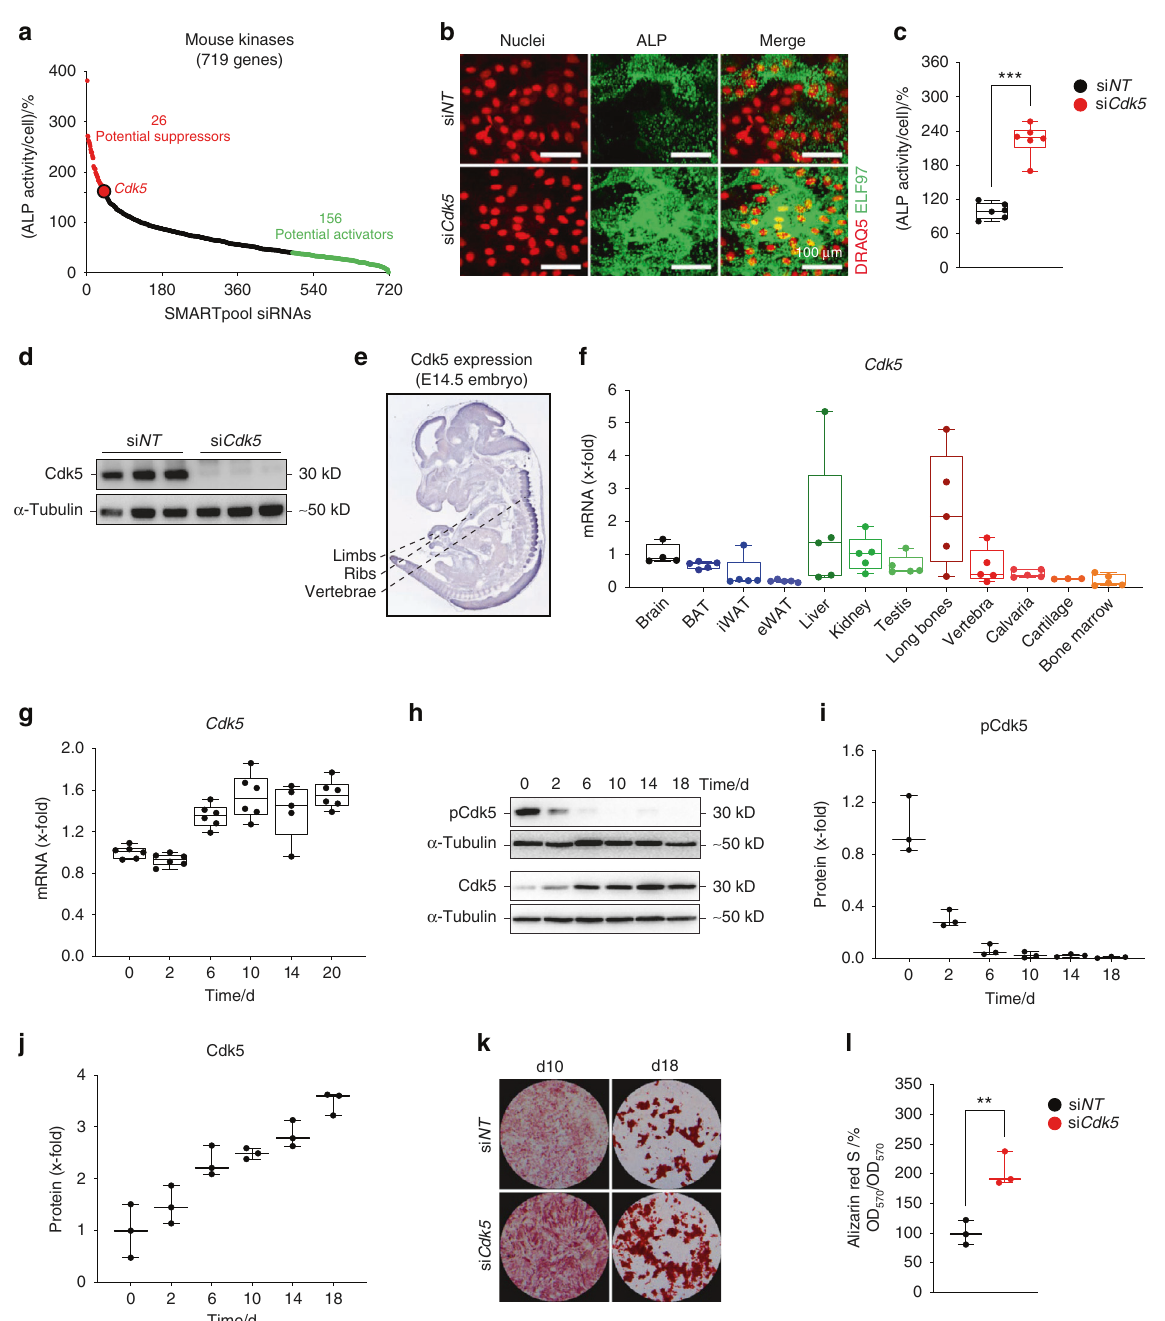
Fig. 1 Identi fi cation of Cdk5 as a suppressor of osteoblast differentiation and mineralization. a Rank plot of the percentage of cellular ALP activity in primary osteoblasts after individual siRNA knockdown of 719 kinases (red dots represent siRNAs increasing ALP ≥ 160%, green dots represent siRNAs decreasing ALP ≤ 40%) b Representative microscopic images of primary murine calvarial osteoblasts upon Cdk5 siRNA knockdown showing nuclear and ALP staining with DRAQ5 (red) and ELF 97 (green), respectively (scale bar: 100 µm). c Quanti fi cation of the percentage of cellular ALP activity upon Cdk5 siRNA knockdown in primary murine calvarial osteoblasts ( n = 6). d Western blot showing Cdk5 protein expression after 8 days of siRNA knockdown in primary murine calvarial osteoblasts ( n = 3). e Cdk5 expression in developing mice at embryonic day 14.5 (E14.5) by in situ hybridization using the online transcriptome atlas Eurexpress 20,21 . f qPCR analysis of Cdk5 mRNA levels in the brain, brown adipose tissue (BAT), inguinal white adipose tissue (iWAT), epididymal white adipose tissue (eWAT), liver, kidney, testis, long bones, vertebra, calvaria, cartilage, and bone marrow ( n = 3 – 5). g qPCR analysis of the Cdk5 mRNA level during osteoblast differentiation in primary murine calvarial osteoblasts ( n = 5 – 6). h Cdk5 phosphorylation (Cdk5 Tyr15 ) and total protein levels by western blotting and, i and j , quanti fi cation during osteoblast differentiation in primary murine calvarial osteoblasts ( n = 3). k Conventional ALP and Alizarin Red S staining ( n = 3) from the primary murine calvarial osteoblasts transfected with non-targeting siRNA (si NT ) or Cdk5 -speci fi c siRNA (si Cdk5 ) at 12 and 20 days post-transfection, respectively. l Quanti fi cation of Alizarin Red S by the acetic acid extraction method from the primary murine calvarial osteoblasts transfected with si NT or si Cdk5 at 20 days post-transfection. Data are represented as box-and-whisker plots with min. to max. as well as with superimposition of all the data points. Statistical differences between groups were determined by unpaired homoscedastic two-tailed Student ’ s t test. * P < 0.05, ** P < 0.01, *** P <